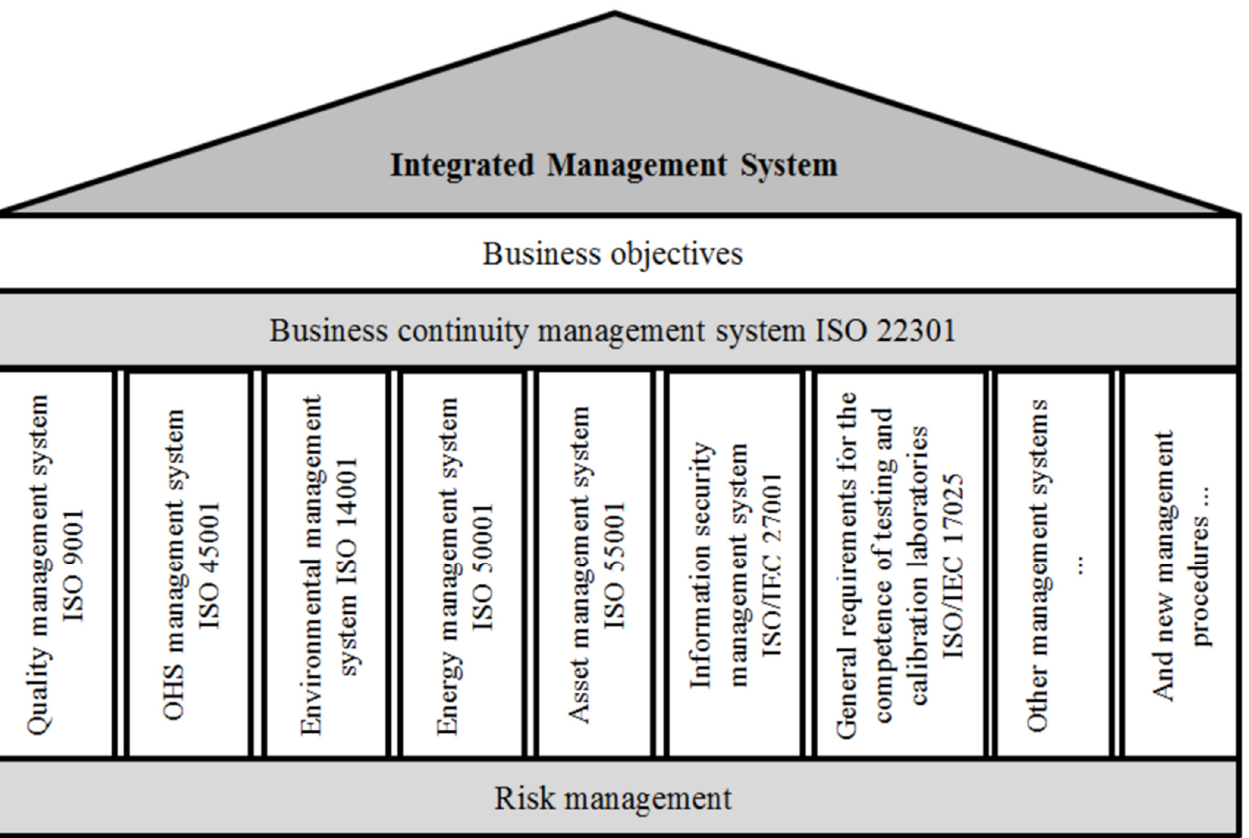
Figure 2. Integration of management systems based on risk assessment [13].